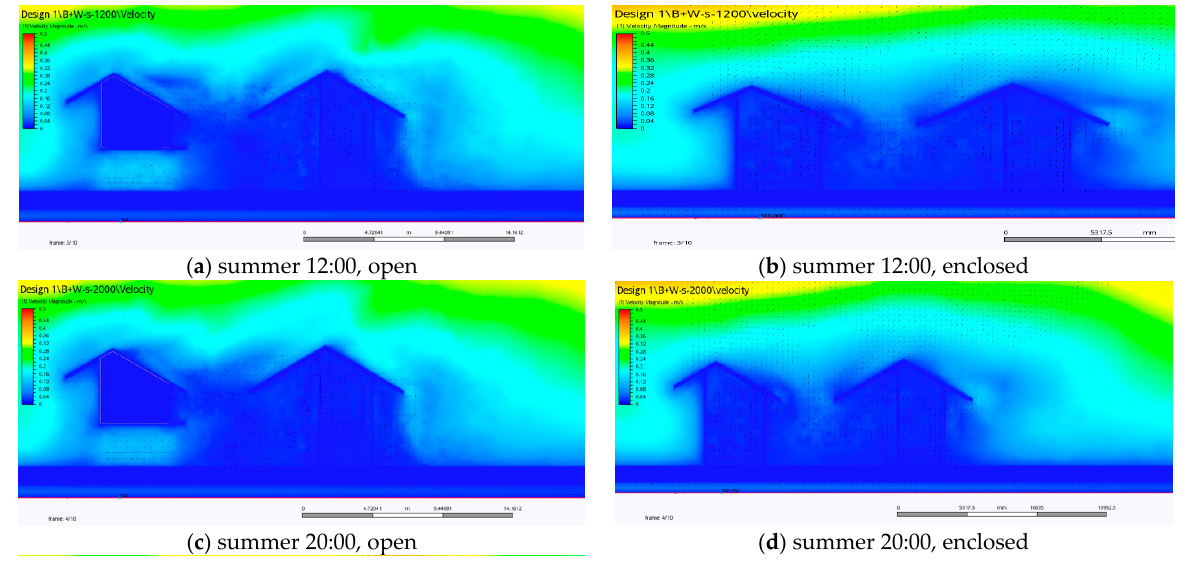
Figure 24. Air temperature distribution by buoyancy effect only: ( a – d ) summer scenarios, and ( e – h ) winter scenarios. Energies 2019 , 12 , x FOR PEER REVIEW